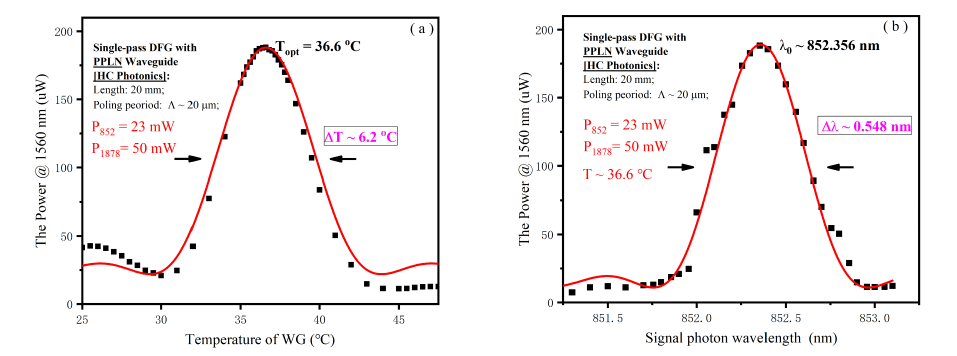
Figure 4. ( a ) Variation curve of DFG conversion power with temperature. ( b ) Variation curve of DFG conversion power with signal photon wavelength. The black squares represent experimental data, and the solid red line represents theoretical fitting